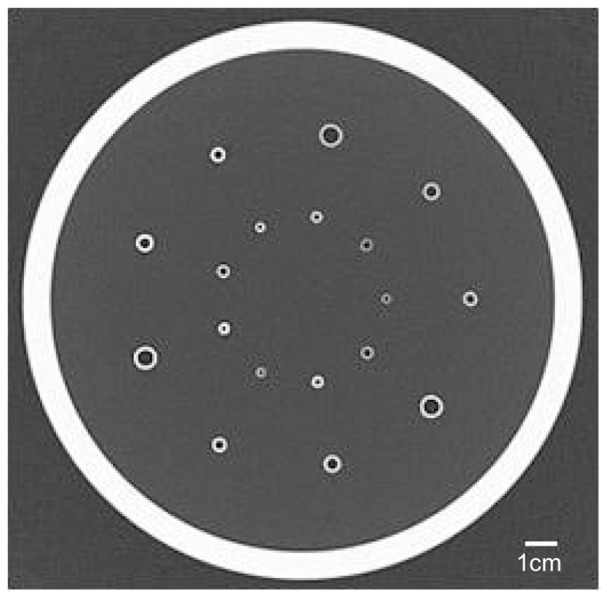
Axial slice computed tomography (CT) image of phantom A.The inner space of the cylindrical container is filled with successive layers of three materials: phenol resin, acrylic foam, and air. A total of 18 tubes (three materials×six sizes) were embedded through each layer (50 or 60 mm in length).